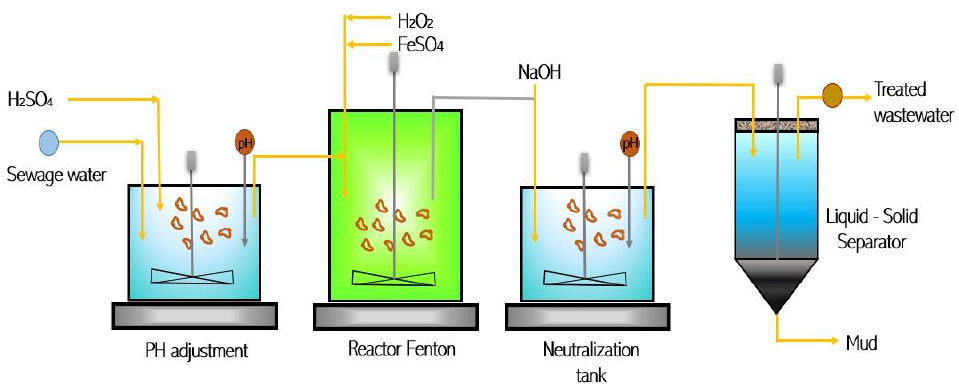
Figure 2. General scheme of the modified Fenton reaction (FR) process.